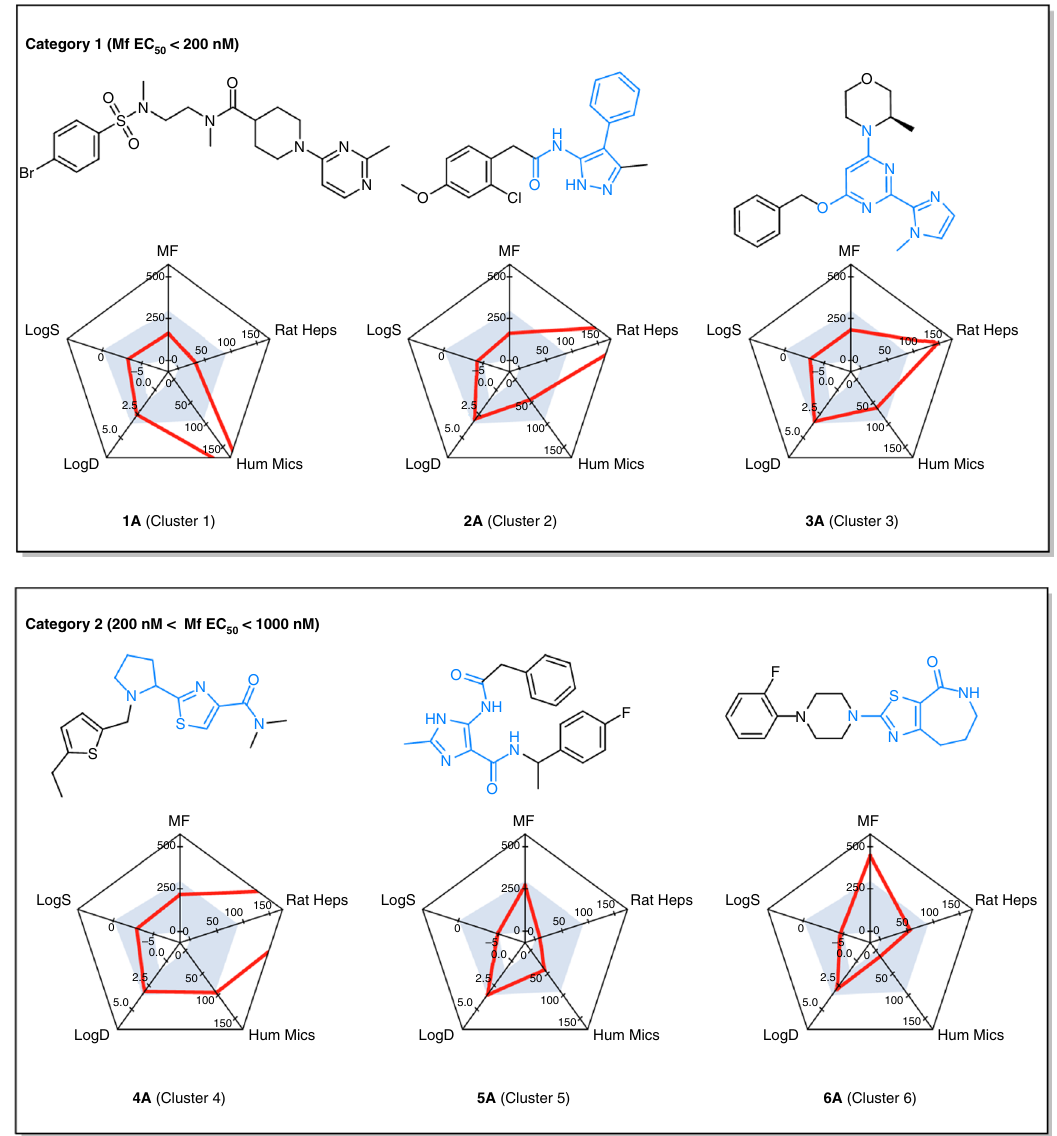
Fig. 4 Anti- Wolbachia potency and drug-like properties of six cluster representatives. Nine hit series were categorised based on the balance between potency in the micro fi larial assay and drug metabolism and pharmacokinetic (DMPK) properties. The fi gure shows the best representatives of the top six clusters. Five axes in the radar plots represent: EC 50 values (nM) in the anti- Wolbachia micro fi larial assay (MF), rat hepatocytes clearance ( µ l min − 1 1 × 10 6 cells − 1 ) (Rat Heps), human microsome clearance ( µ l min − 1 mg − 1 ) (Hum Mics), LogD 7.4 (LogD) and log value of aqueous solubility in pH 7.4 PBS buffer ( µ M) (LogS). The core of each cluster chemotype is highlighted blue within the chemical